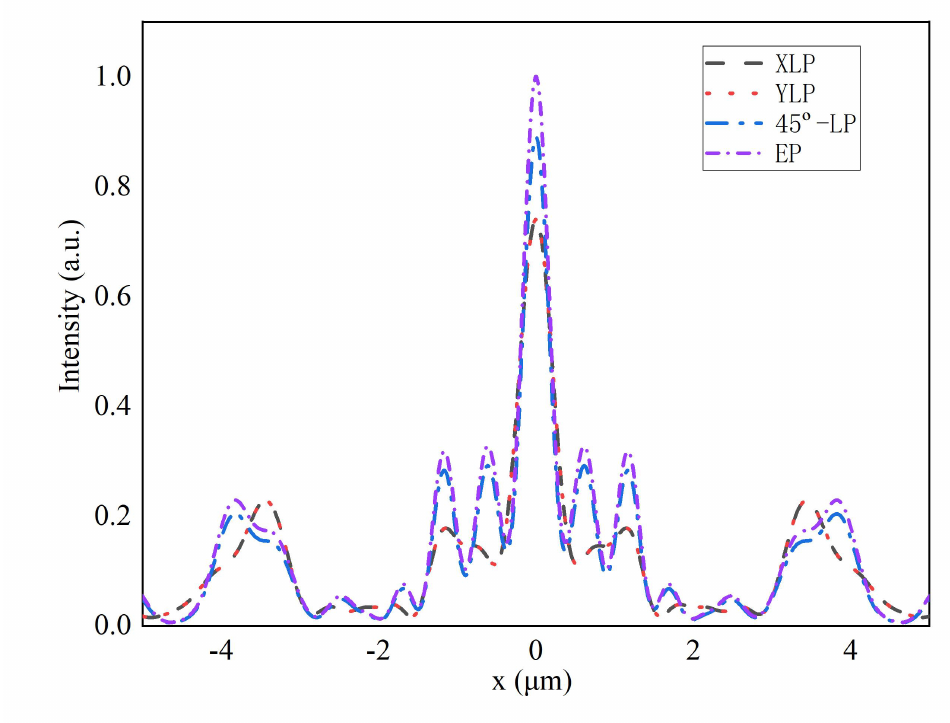
Figure 8. Numerical intensity profiles along axial planes at various incident wavelengths for Intensity distributions of the corresponding focal